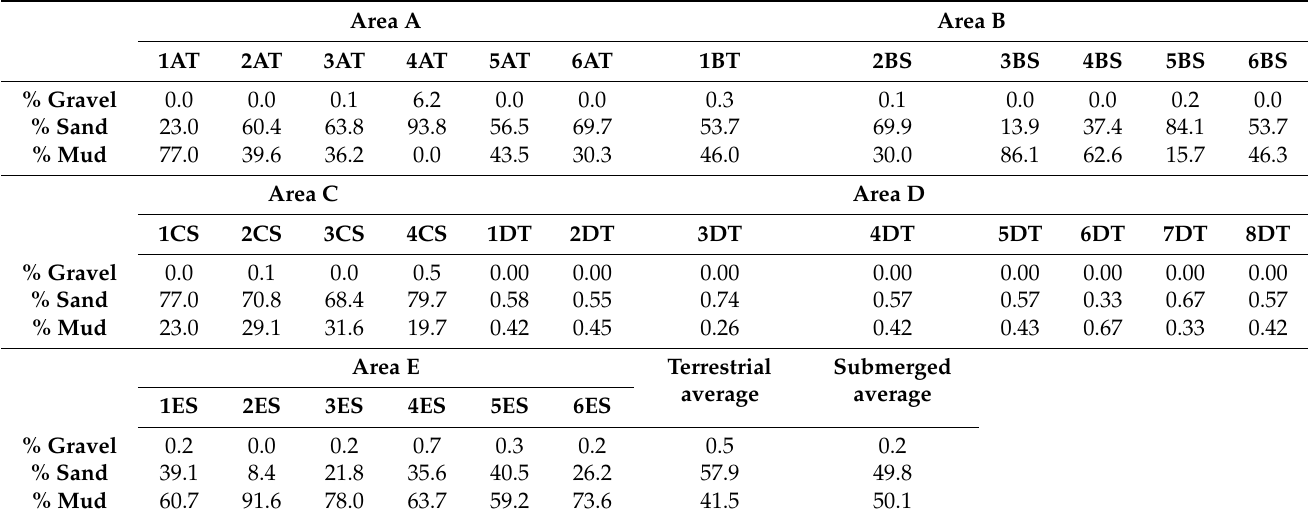
Table 5. Gran size composition of each studied sample and average values for the terrestrial and the submerged